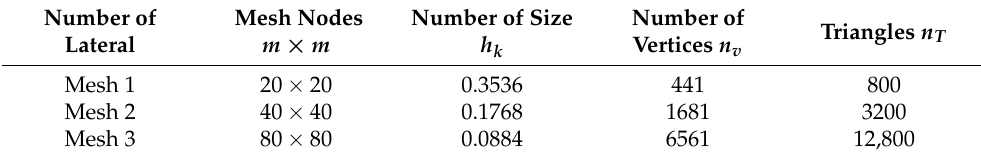
Table 1. Details of the meshes.